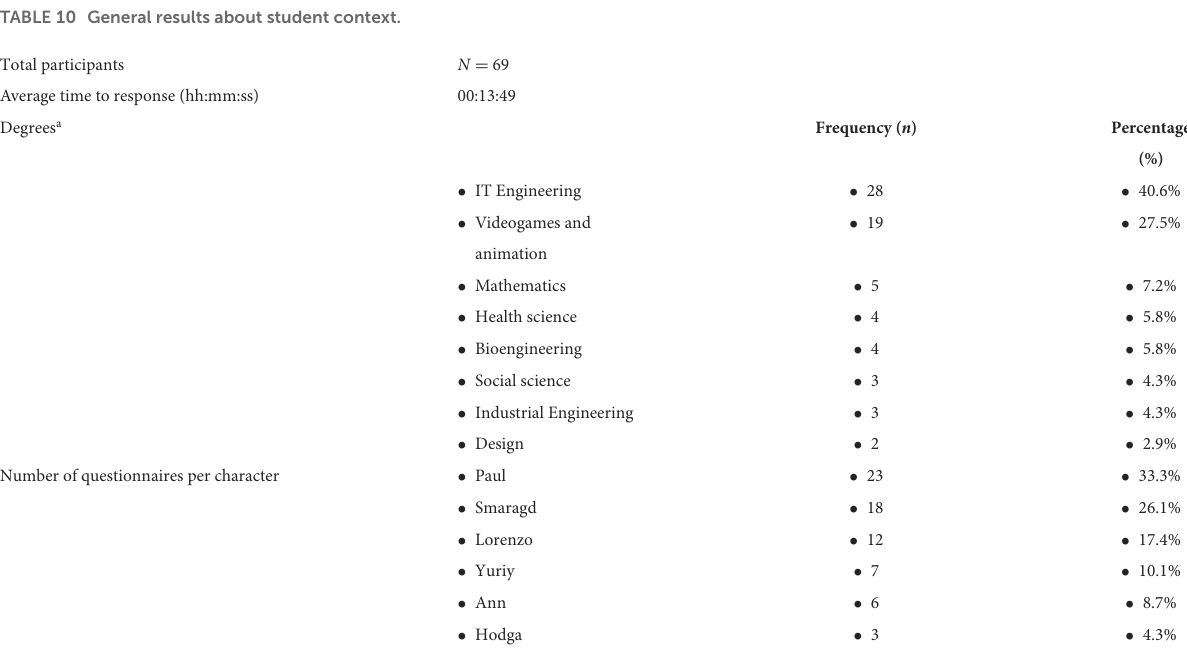
TABLE 10 General results about student